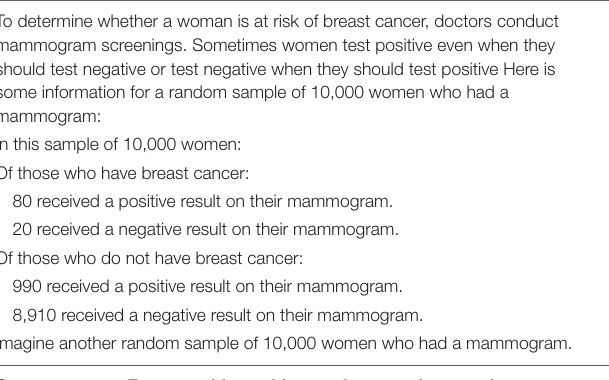
TABLE 5 | Example presentations without reference class totals for the mammography